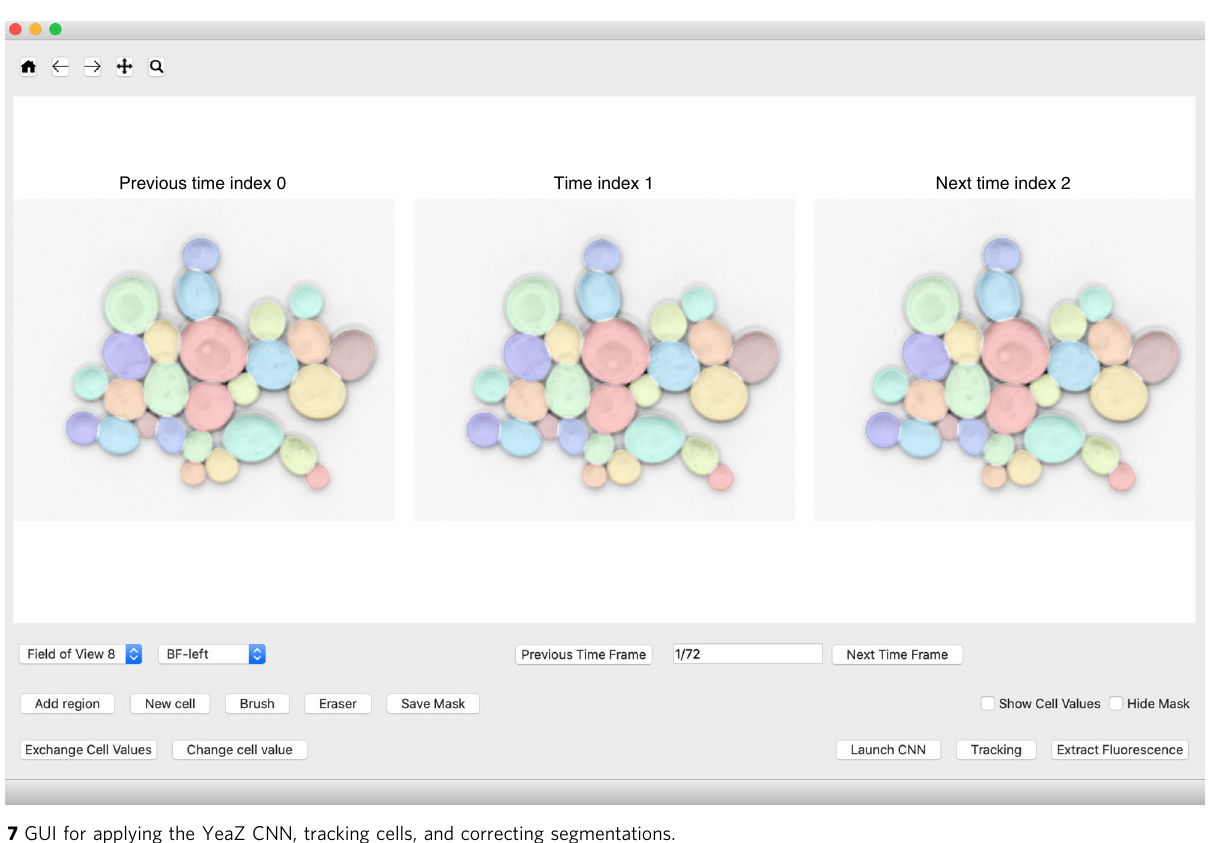
Fig. 7 GUI for applying the YeaZ CNN, tracking cells, and correcting segmentations.